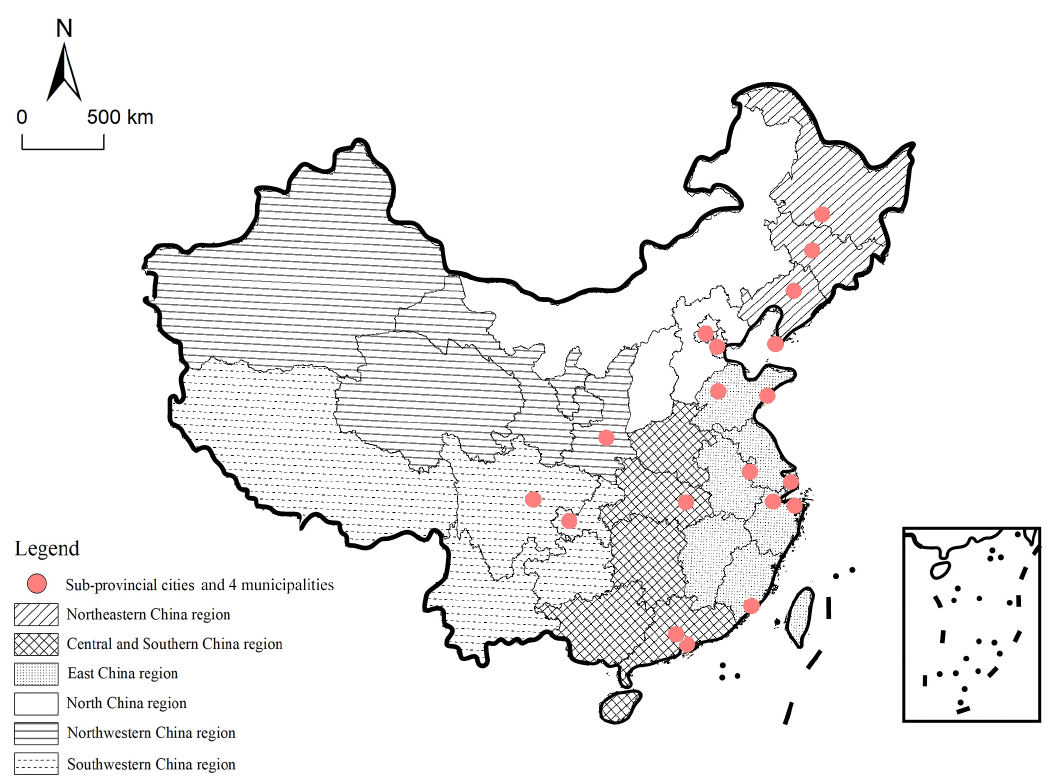
Figure 2. Location of 15 sub-provincial cities and 4 municipalities (Source: repainted by the author, http://bzdt.ch.mnr.gov.cn/browse.html?picId=%224028b0625501ad13015501ad2bfc0002%22, accessed on 26 November 2021).